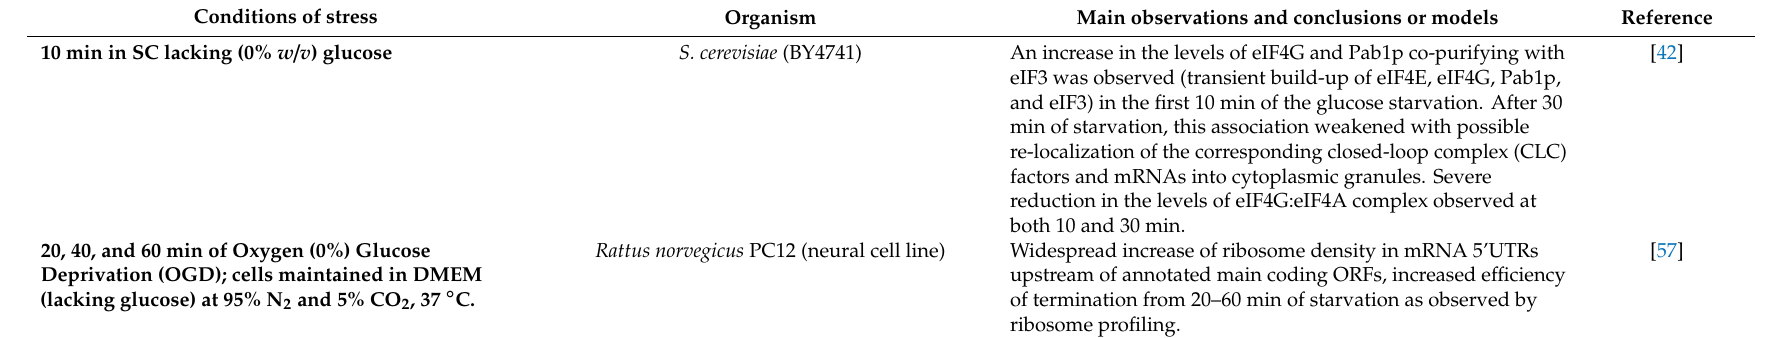
Table 3. Regulation by targeting scanning of mRNA 5’UTRs during glucose starvation